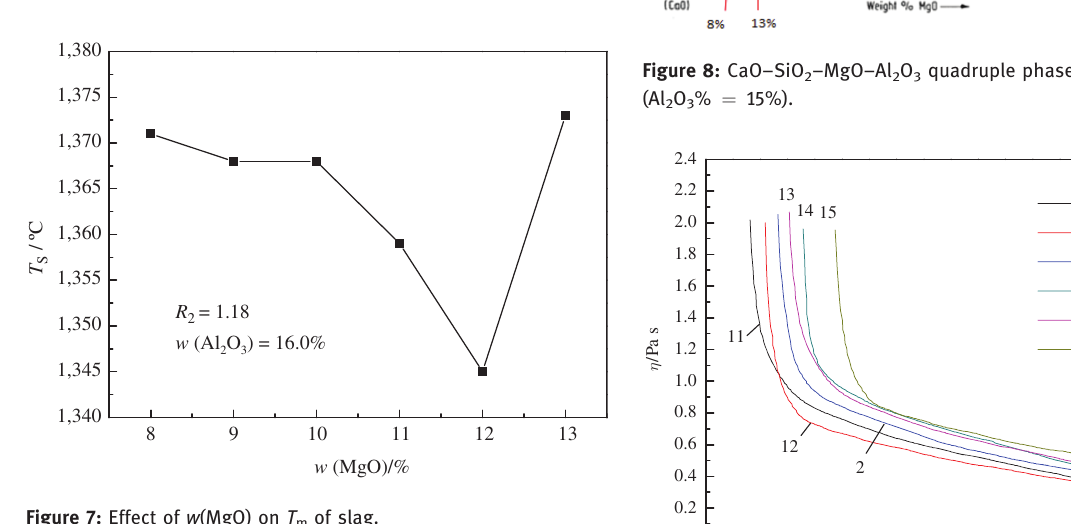
Figure 6: Effect of w (MgO) on viscosity of slag.